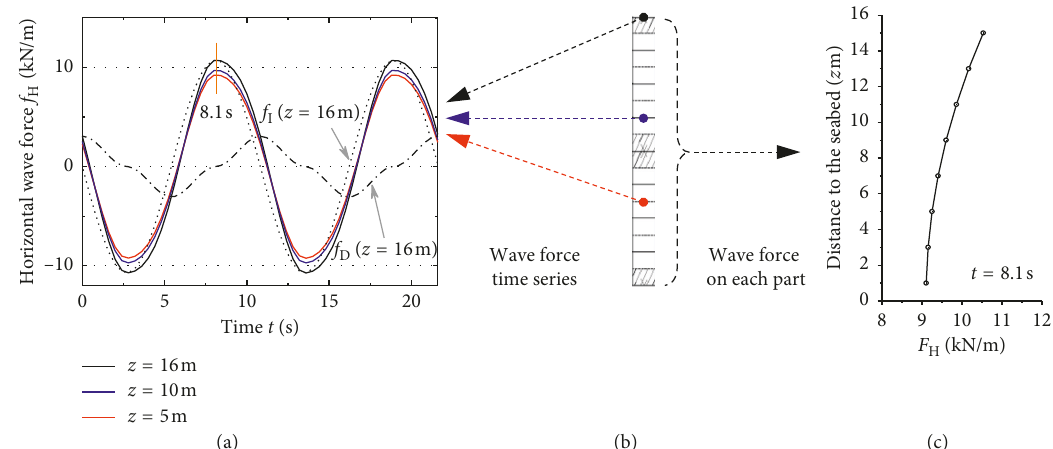
Figure 4: Horizontal wave forces on a pile. (a) Time series at different heights. (b) Schematic diagram of the division. (c) Maximum wave forces along the